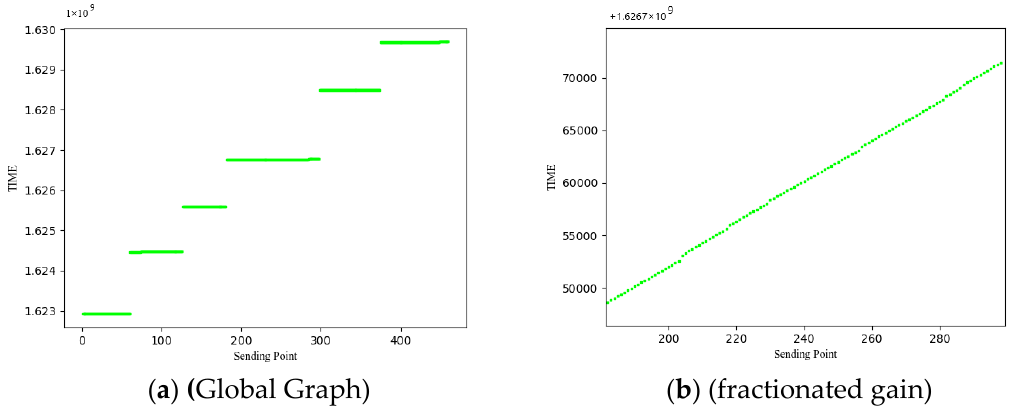
Figure 1. Velocity and course thermodynamic profile. ( a ) Speed; ( b ) course.